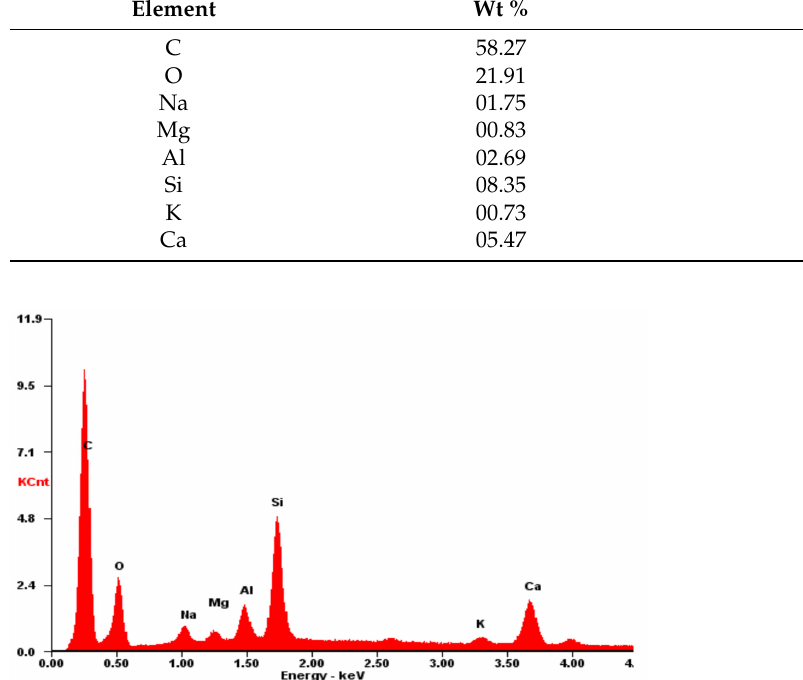
Figure 14. Exemplary EDS spectrum recorded for a textolite material with enhanced degradation effects. The contribution of the elements present in the fibreglass support, especially silicon,